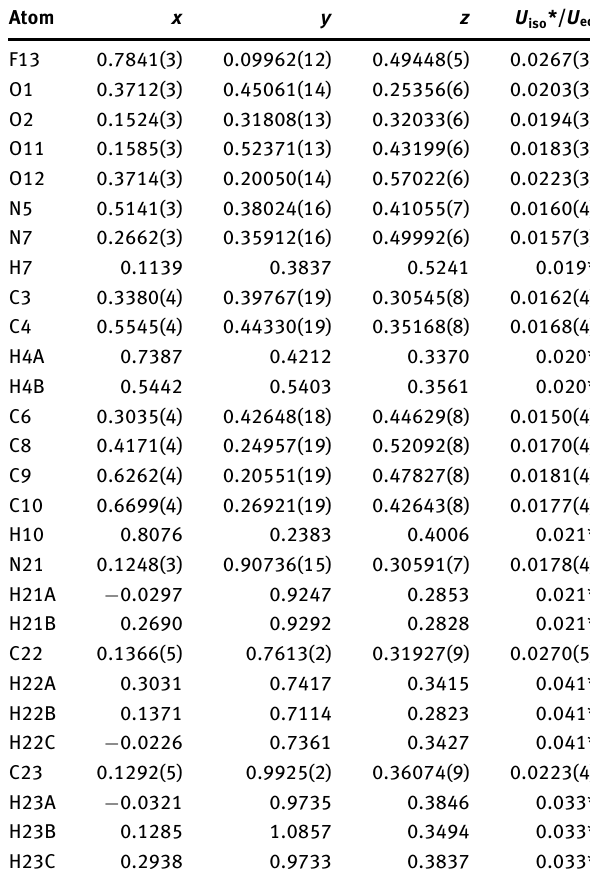
Table 2: Fractional atomic coordinates and isotropic or equivalent isotropic displacement parameters (Å 2